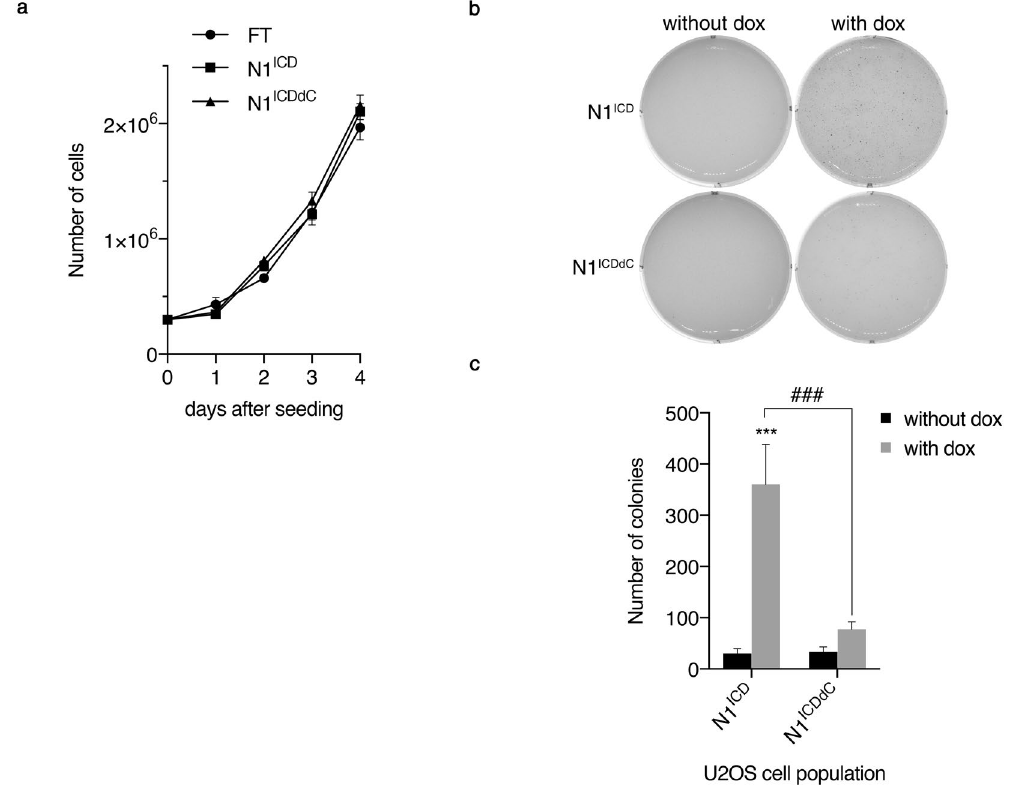
Figure 5. N1 ICD promotes anchorage-independent growth. ( a ) The parental U2OS Flp-In TM T-REx TM (FT) population, and stable populations of U2OS GFP-N1 ICD (N1 ICD ) and GFP-N1 ICDdC (N1 ICDdC ) were seeded on day 0 and growth was assessed by cell counting for 4 days. The experiment was performed 4 times in duplicate. Data are expressed as mean ± SEM. ( b ) Cells from stable populations of U2OS GFP-N1 ICD (N1 ICD ) and GFP-N1 ICDdC (N1 ICDdC ) were seeded in soft-agarose and left uninduced (without dox) or induced with doxycycline (with dox). After 3–4 weeks, colonies were stained. ( c ) Same as ( b ). Stained colonies were counted using the CellProfiler software. A graphical representation of 10 independent experiments is shown. *** p < 0.001 as compared with the uninduced cells (without dox). ### p <